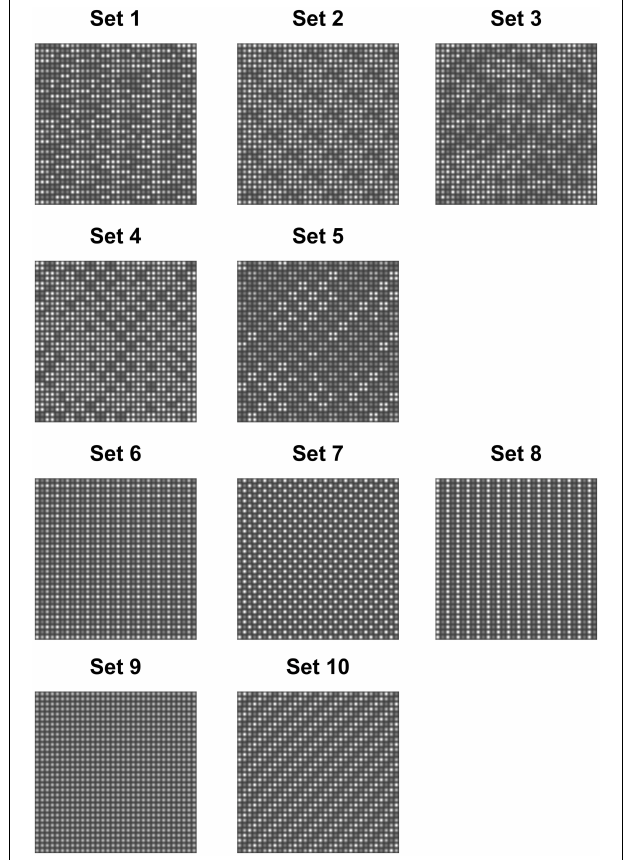
FIGURE 1 | Examples of generated textures ( β = 1 ) used in the experiment. Texture sets 1–5 have a different appearance across realizations, whereas Texture sets 6–10 have the same appearance (up to a shift) in different